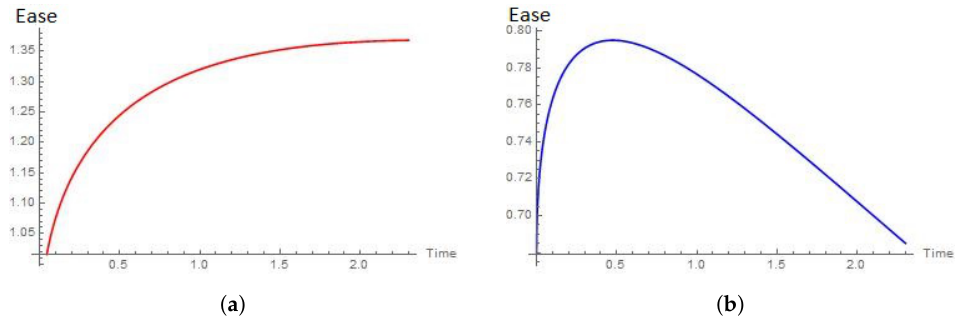
Figure 13. Ease of the extraction when the shape parameter of Weibull distribution is δ 1 = 1 of the extraction for Weibull’s player when δ 1 = 1 δ 2 = 1 . 2